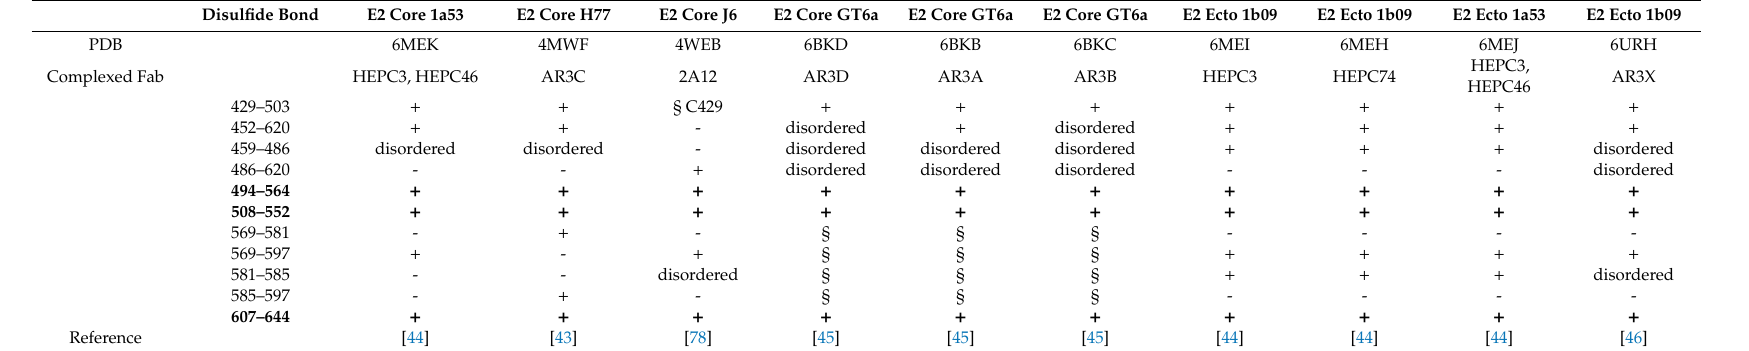
Table 1. Disulfide bridge network present in the E2 core and ectodomain